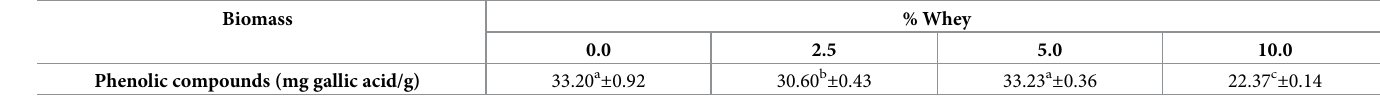
Table 5. Total extractable phenolic content.